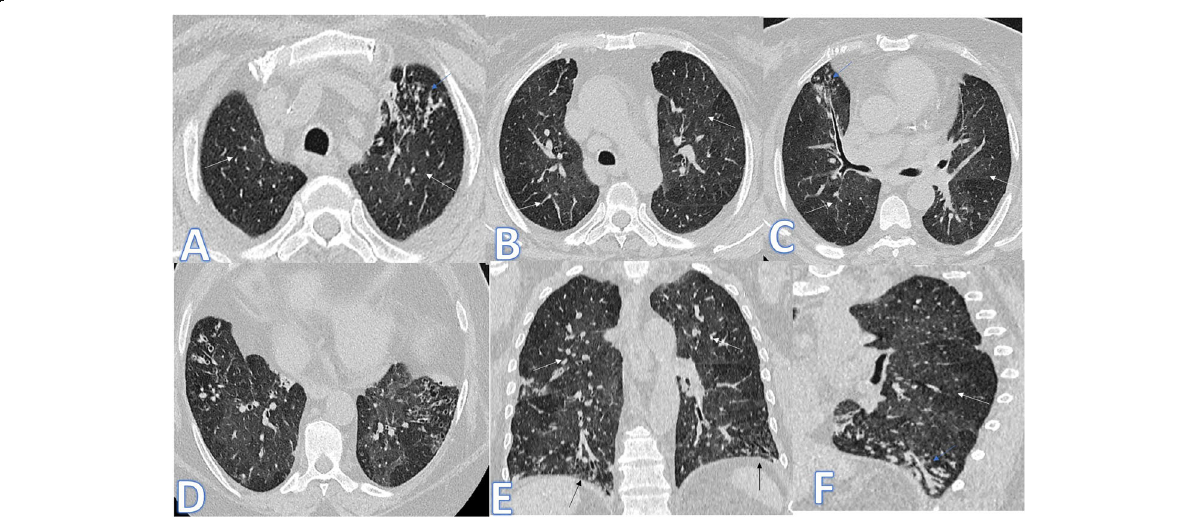
Fig. 18 A 61-year-old female patient with bronchial asthma presented with cough and wheezy chest. On CT, there were bilateral mosaic patches of GGO due to air trapping (white arrows) with left upper lobe tree-in bud and subsegmental atelectasis (blue arrows), peribronchial thickening, and bilateral mild basal bronchoectatic changes (black